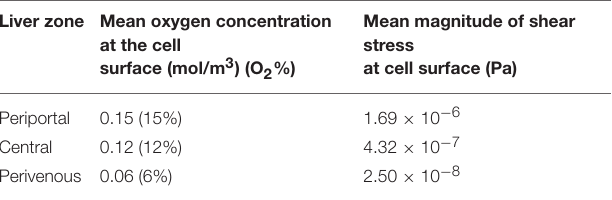
lysate and media and LDH released then calculated in the media as a proportion of the total.